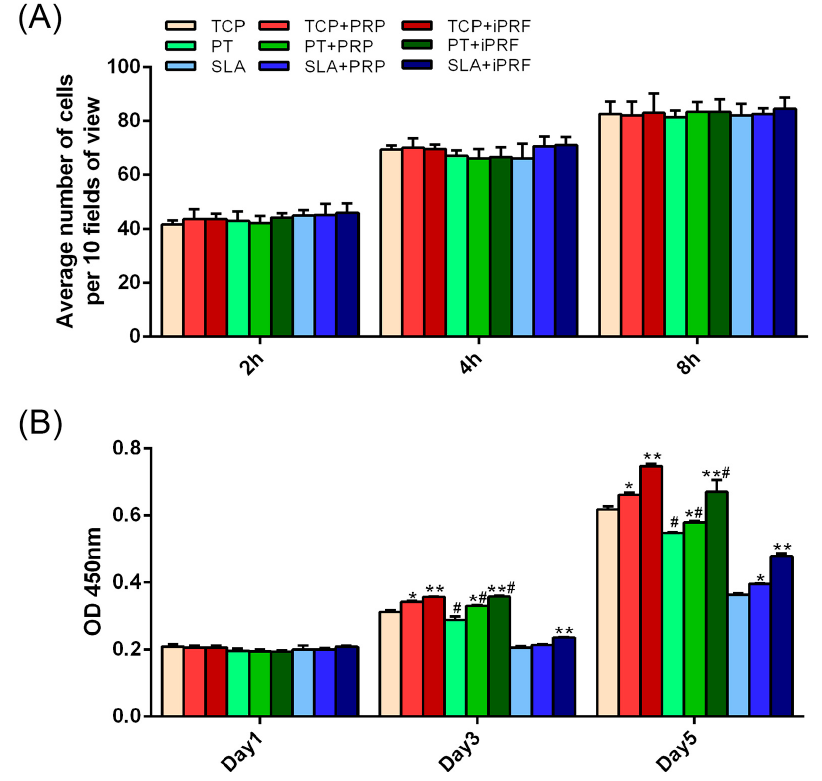
Figure 3. Effect of surface topography in combination with PRP and i-PRF on the adhesion and proliferation of human gingival fibroblasts. ( A ) Cell adhesion at 2, 4 and 8 h and ( B ) Cell proliferation at 1, 3 and 5 days. (* denotes significant difference between control and experimental group, p < 0.05; ** denotes significantly higher than all other groups, p < 0.05; # denotes significant difference between PT and SLA surfaces p < 0.05).